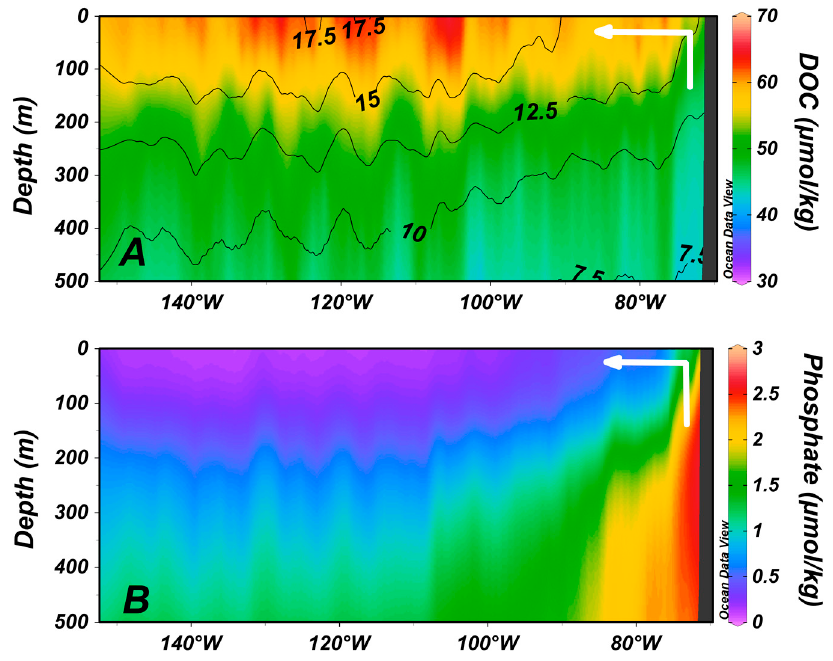
Figure 3. Vertical sections of ( A ) DOC ( μ molC/kg) overlain by temperature contours (°C) and ( B ) phosphate ( μ molP/kg) along ocean section P06 (see Figure 2 for location). White arrows schemati- cally indicate upwelling along the coast of Chile.